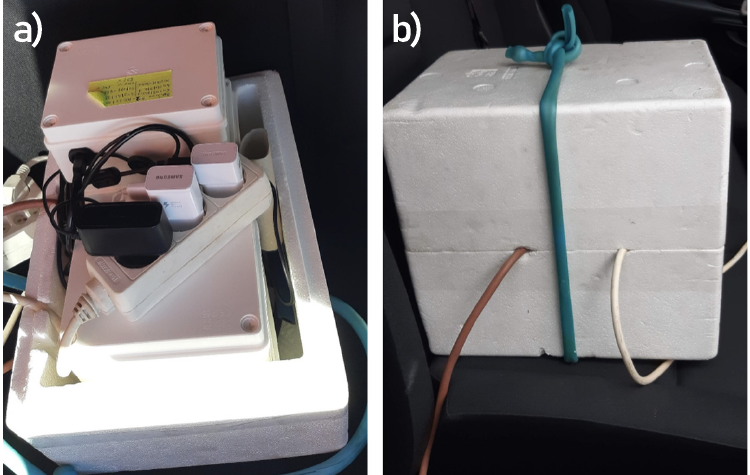
Figure 2. Devices under test placed in the exposure box: ( a ) inside the box, we placed 5 of our units with a power cord for each of them. ( b ) The box was closed, and the air was pumped inside the box via a 6 L/min pump to ensure a constant air flow. The air was taken from the same pipe used by the reference monitoring